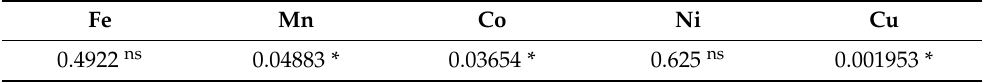
Figure 3. Time dependence of ion concentrations in bacterial and control groups. Table 2. The Wilcoxon signed-rank test results between bacterial and control groups.